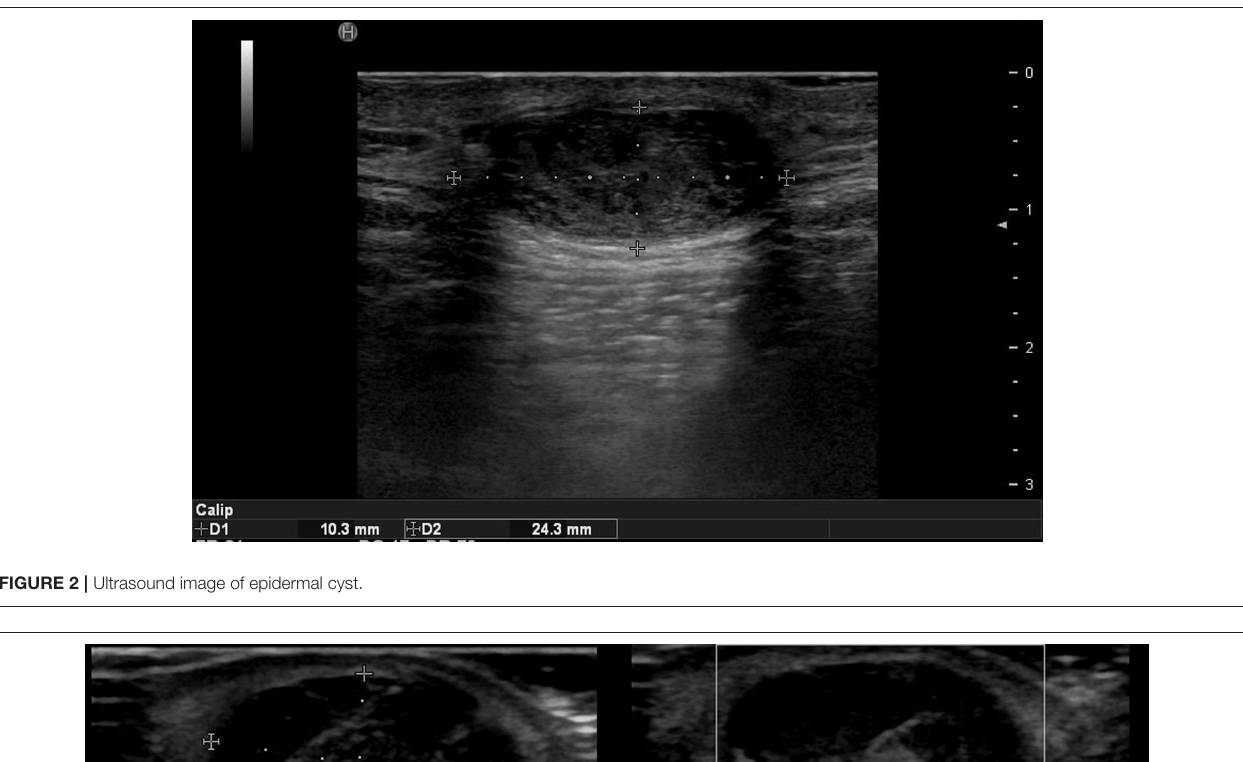
FIGURE 2 | Ultrasound image of epidermal cyst.